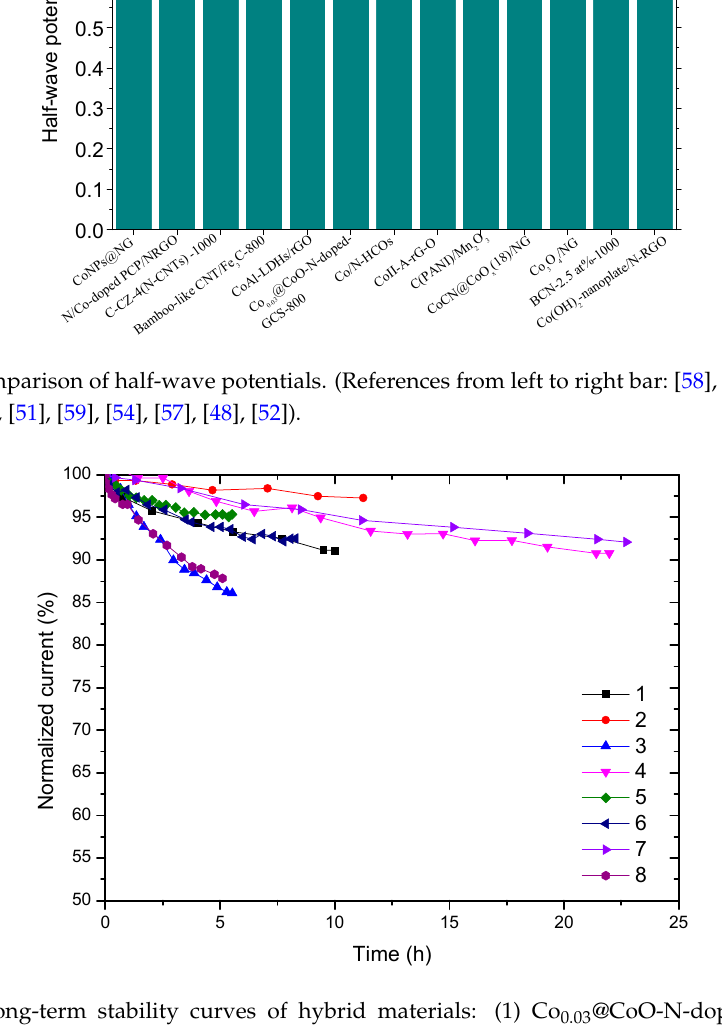
Figure 3. Comparison of half ‐ wave potentials. (References from left to right bar: [58], [53], [55], [56],